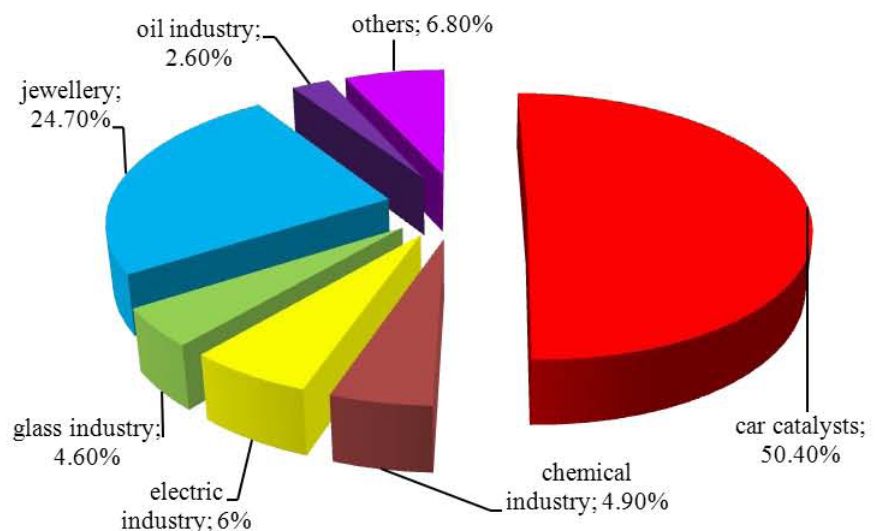
Figure 1. The main emission sources of platinum metals in Europe (2006). Automobile catalysts are responsible to the main percentage of emissions of platinum metals into the environment (50.40%). Other sources are by-products in jewellery (24.7%), electric industry